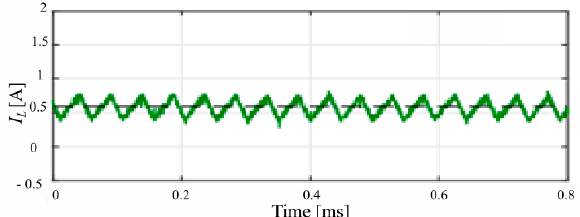
Figure 12. Experimental result using PIDF: zoom of the inductor current sensor output in steady-state condition.